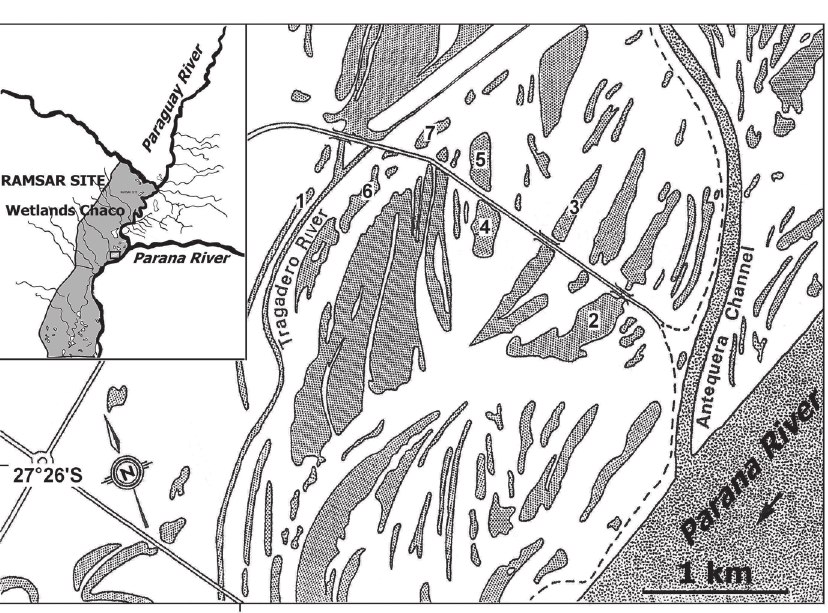
Fig. 1. Distribution of 7 vegetated wetlands across the studied alluvial floodplain.